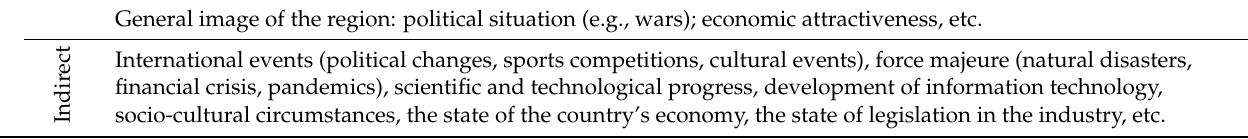
a l D i r n e r x t E